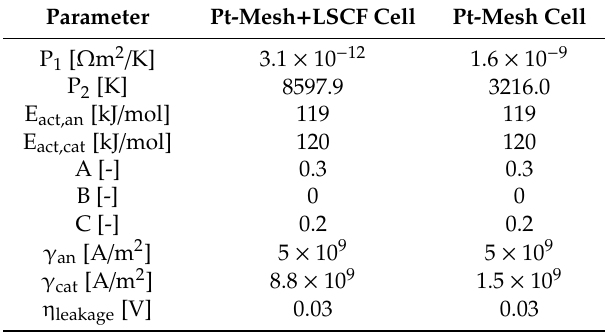
Table 1. Kinetic parameters detected through EIS analysis and I–V